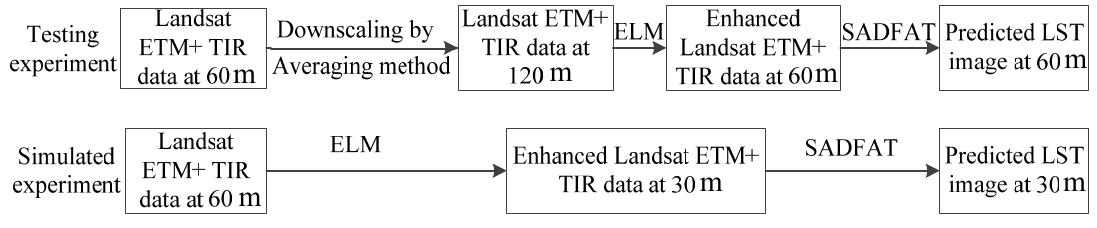
Figure 4. The flowchart of the testing and simulated